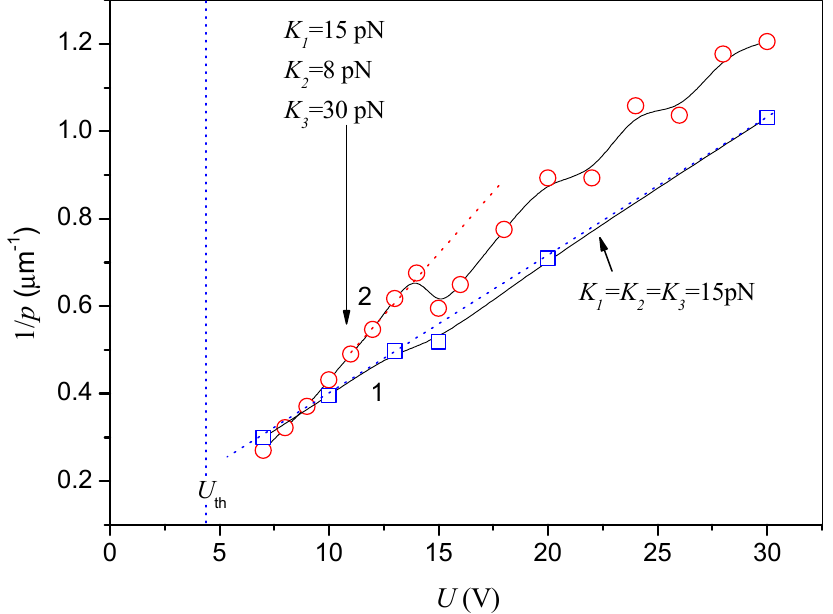
Figure 4. Dependence of the spatial frequency ( 1/p ) of the induced grating on the applied voltage for two series of elastic coefficients: (1) K 1 = K 2 = K 3 = 15 pN; (2) K 1 = 15 pN, K 2 = 8 pN, K 3 = 30 pN. The thickness of the LC layer d = 2 μ m.